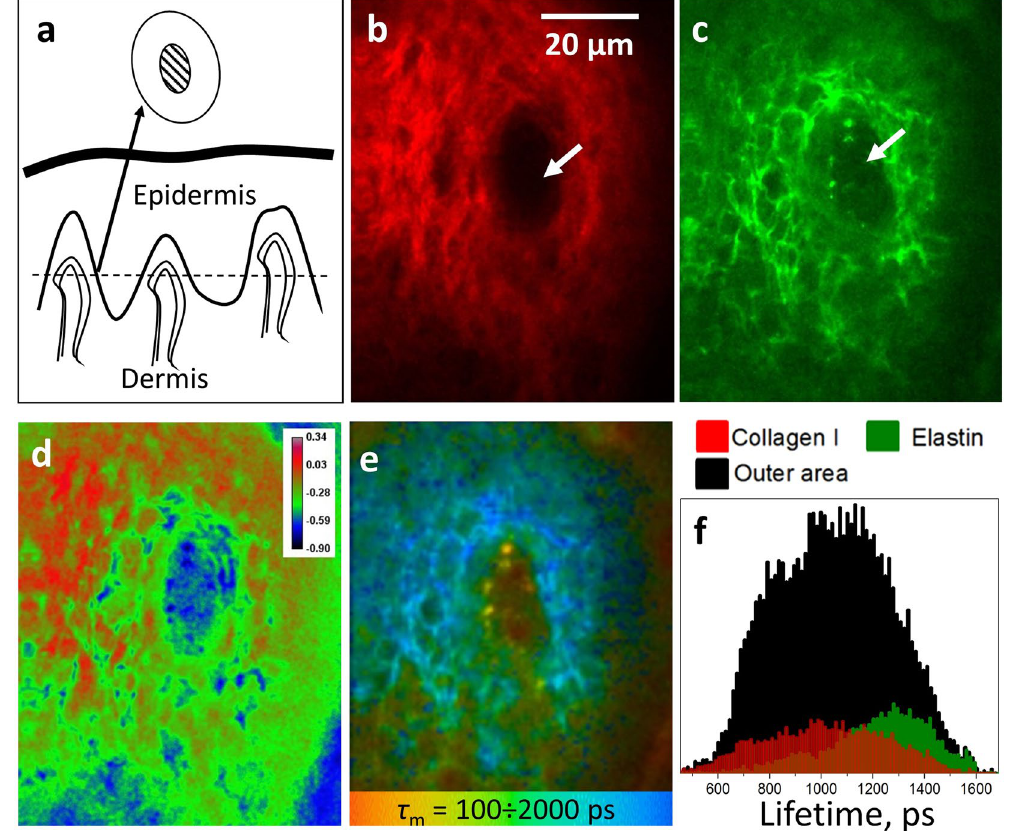
Figure 4. ( a ) Schematic representation of the skin structure. The dashed line corresponds to the plane of the papillary dermis cross-section measured with MPT, the outer and inner circles correspond to the cross-section of dermal papilla and the inner area around capillary. ( b , c ) Two-photon images of the dermal papilla: SHG and TPAEF signals, respectively. The white arrows correspond to the “hollow” area inside the papilla. ( d ) Spatial distribution of the SAAID index (SAAID = (SHG – TPEAF)/(SHG + TPEAF)) in the dermal papilla. ( e ) FLIM image of the dermal papilla, pixel colors correspond to different values of the mean fluorescence lifetime τ m in the 100 ÷ 2000 ps range. ( f ) Mean lifetime distributions obtained for the outer area, positive SAAID ( > 0.15, collagen I) and negative SAAID ( − 0.4 ÷ − 0.35) regions of the dermal papilla (see text for